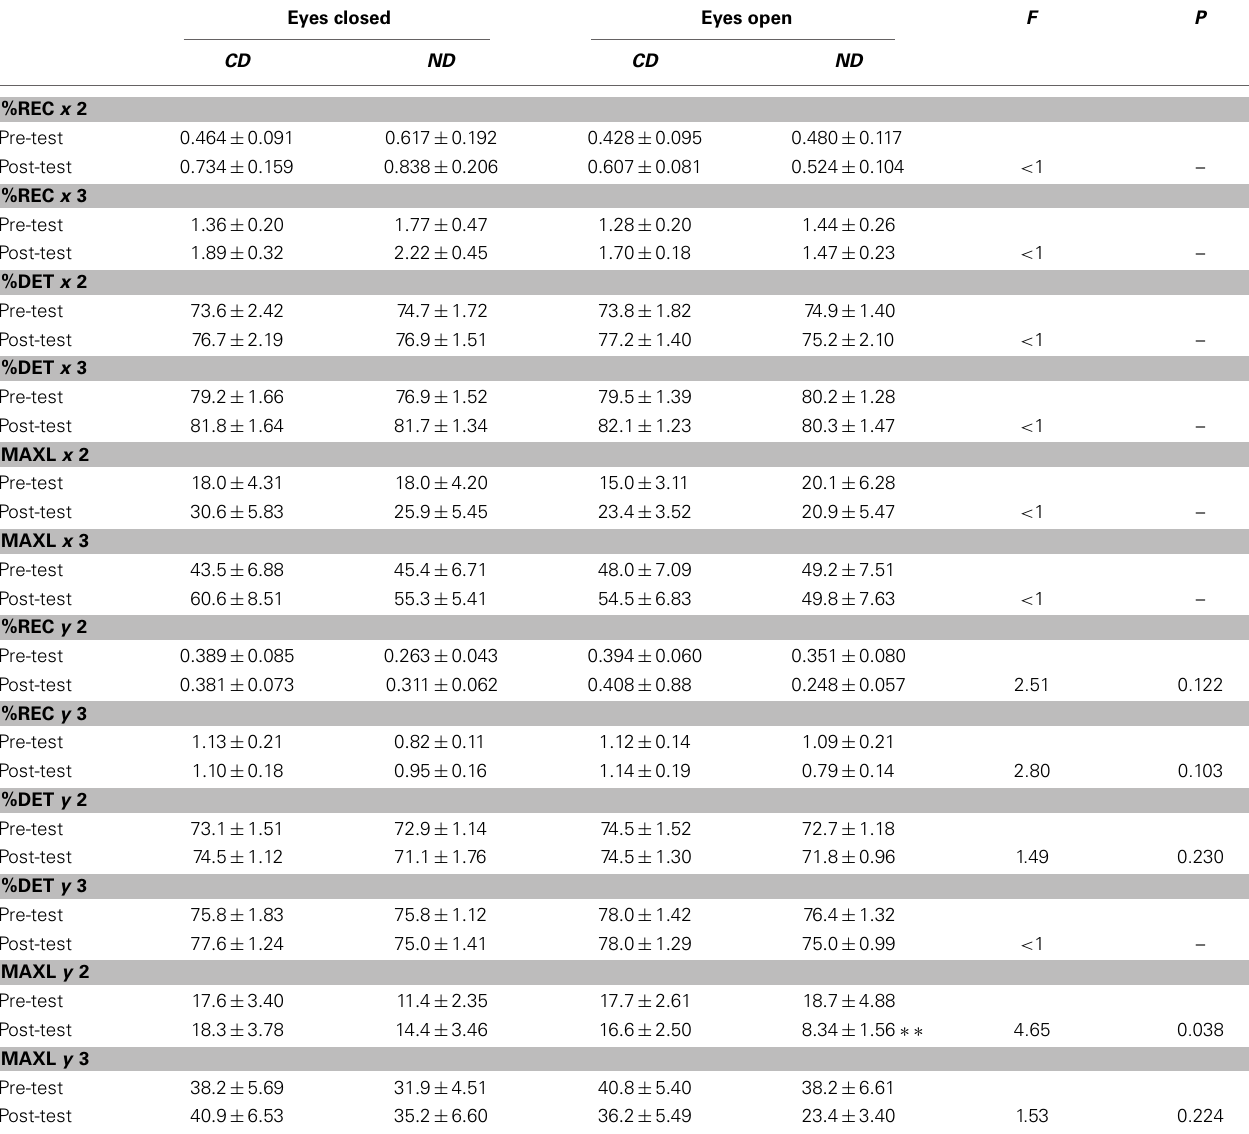
Table 4 | Mean ± SE of recurrence quantification analysis for the groups of participants (CD, contemporary dance; ND, no dance). Eyes closed Eyes open F